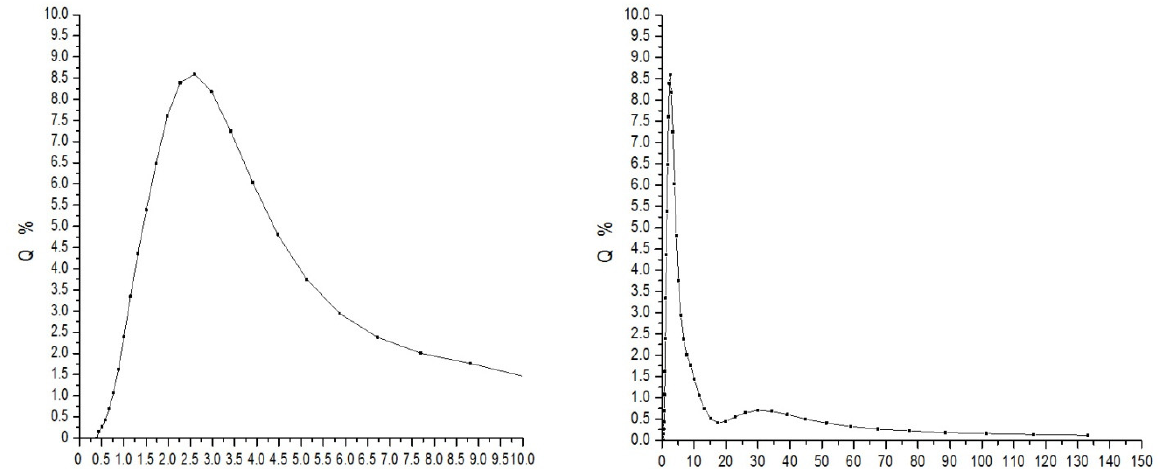
Figure 3. Granulometric composition of the discharge from the classifier.